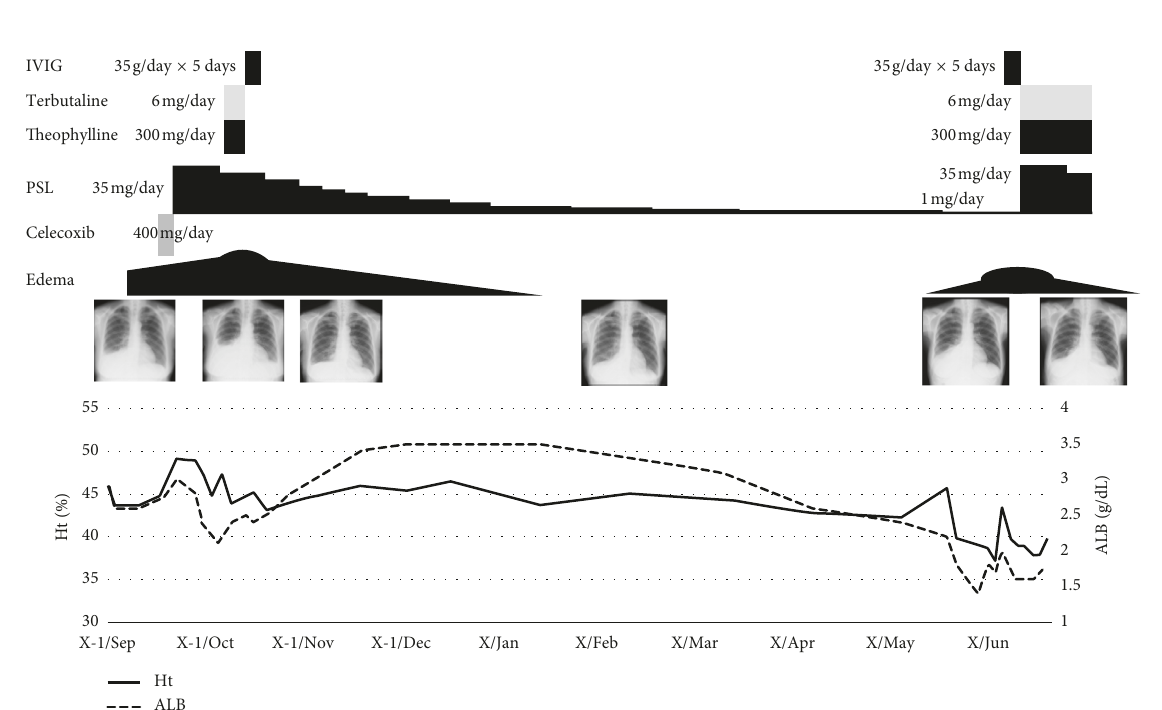
Figure 1: Clinical course of the present case. ALB: albumin; Ht: hematocrit; IVIG: intravenous immunoglobulin; PSL: